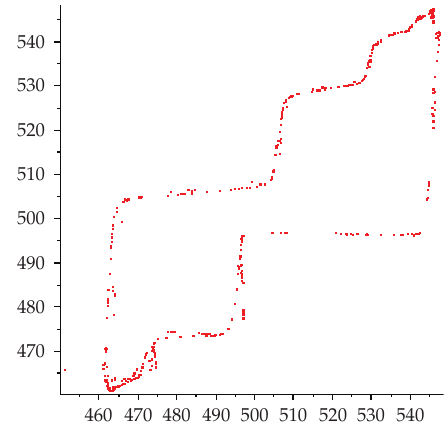
Figure 6: (cid:2) y (cid:2) t − 1 (cid:3) ,y (cid:2) t (cid:3)(cid:3) in the deterministic case for d (cid:7) 0 . 6.